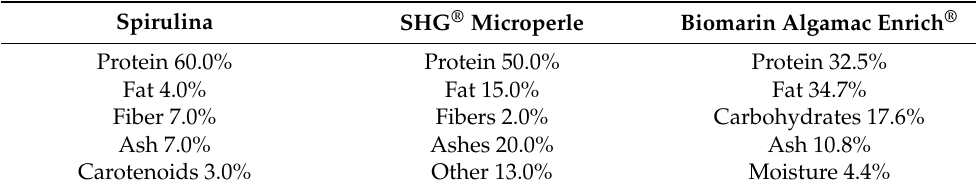
Table 2. Food elemental composition of spirulina (A), SHG ® Microperle (B) and Biomarin Algamac Enrich ®